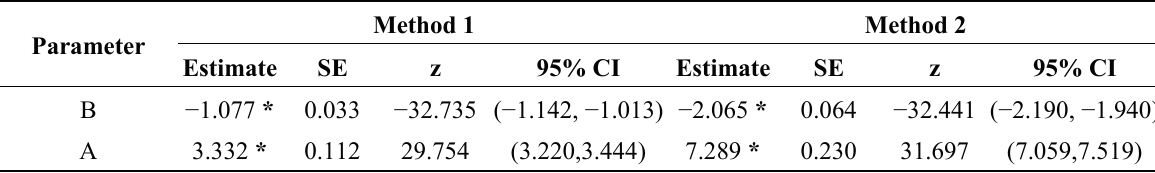
Table 2. The probability of payment interval unit